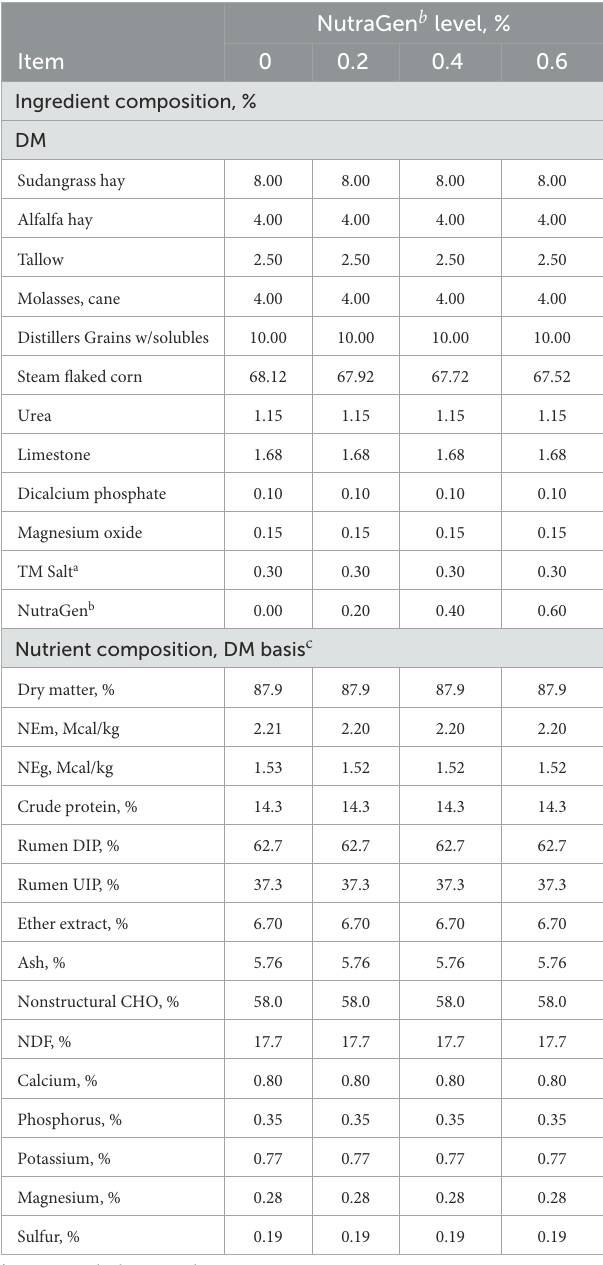
TABLE 1 Composition of experimental diets (DM basis). reading of the muscle at the 12th rib; subcutaneous fat (cm) over from the chine bone end (adjusted for unusual fat distribution); kidney, pelvic and heart fat (KPH) as a percentage of HCW;